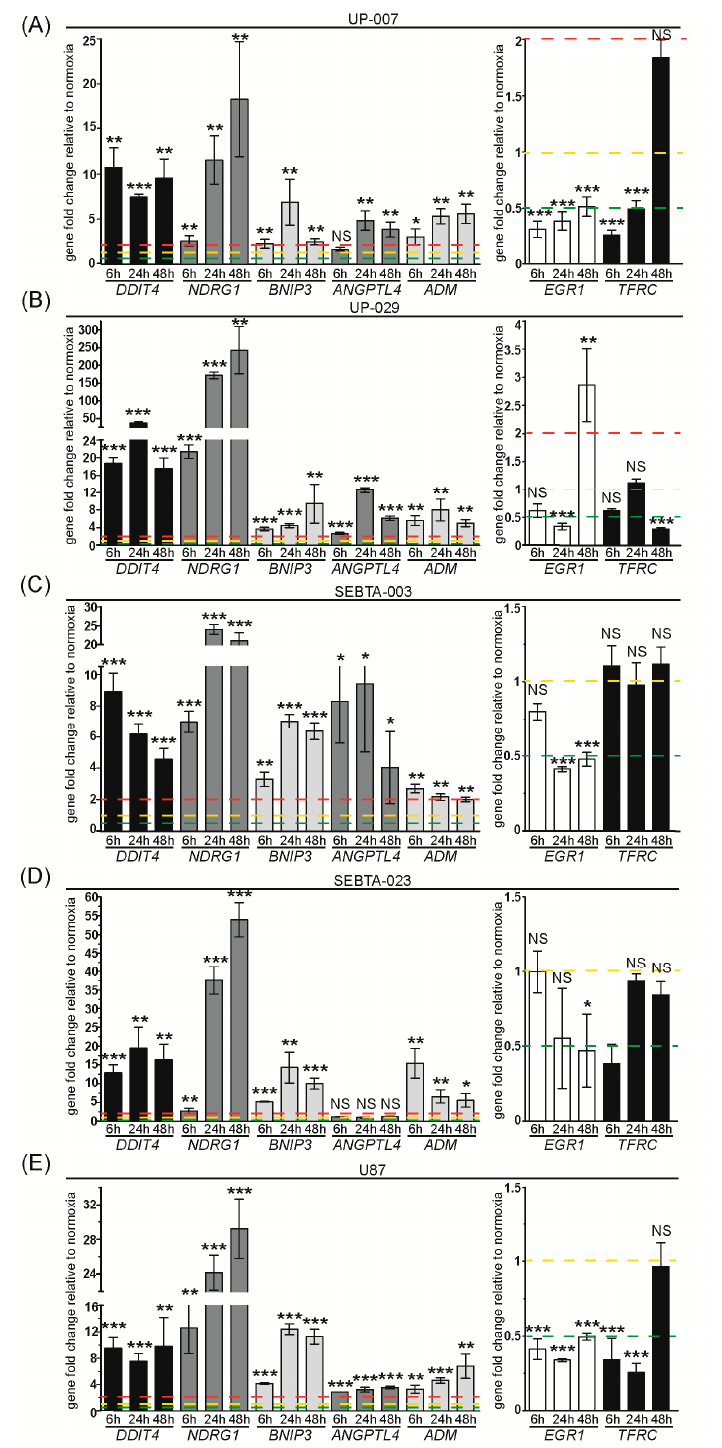
Figure 6. Analysis of varied functions genes in hypoxic GB cells. ( A ) UP-007; ( B ) UP-029; ( C ) SEBTA-003; ( D ) SEBTA-023; or ( E ) U87 cells were incubated under normoxia (21% O 2 ) or hypoxia (1% O 2 ) for the times indicated. RNA extraction was performed and gene expression was determined by RT-qPCR. Gene expression levels were normalized to RPLP0 mRNA using the 2 − ∆∆ CT method [13]. Error bars represent the Standard Deviations from the median value of at least three independent experiments, performed in triplicate. Statistical analysis was evaluated using two-tailed Student’s t-test, comparing each hypoxia time-point to the respective normoxic control. In every case a p value of less than 0.05 (*), less than 0.01 (**) and 0.001 (***) was considered statistically